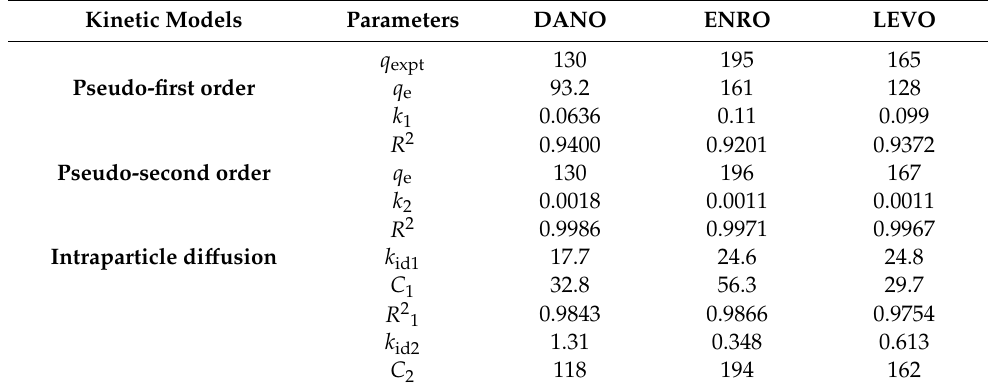
Table 4. Parameters for the various kinetic models fitted onto data obtained for adsorbate solutions and